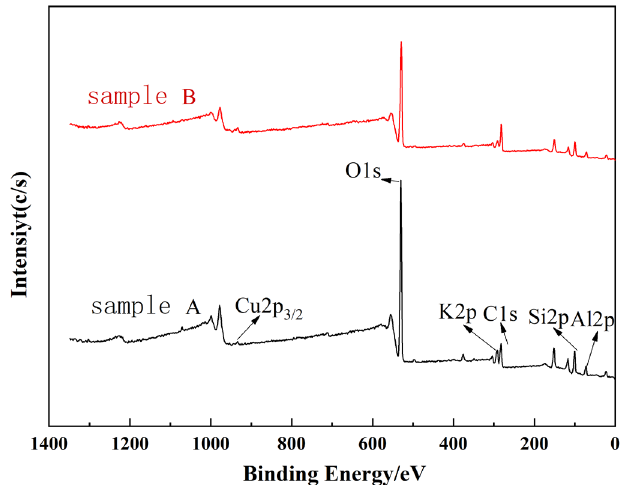
Figure 10. XPS spectra of muscovite samples (pH = 12, c(Sodium oleate) = 9.20 × 10 −4 mol/L, c(Cu 2+ ) = 6 × 10 −5 mol/L). Table 4. Electron binding energy and relative content of major elements on the surface of the sample.